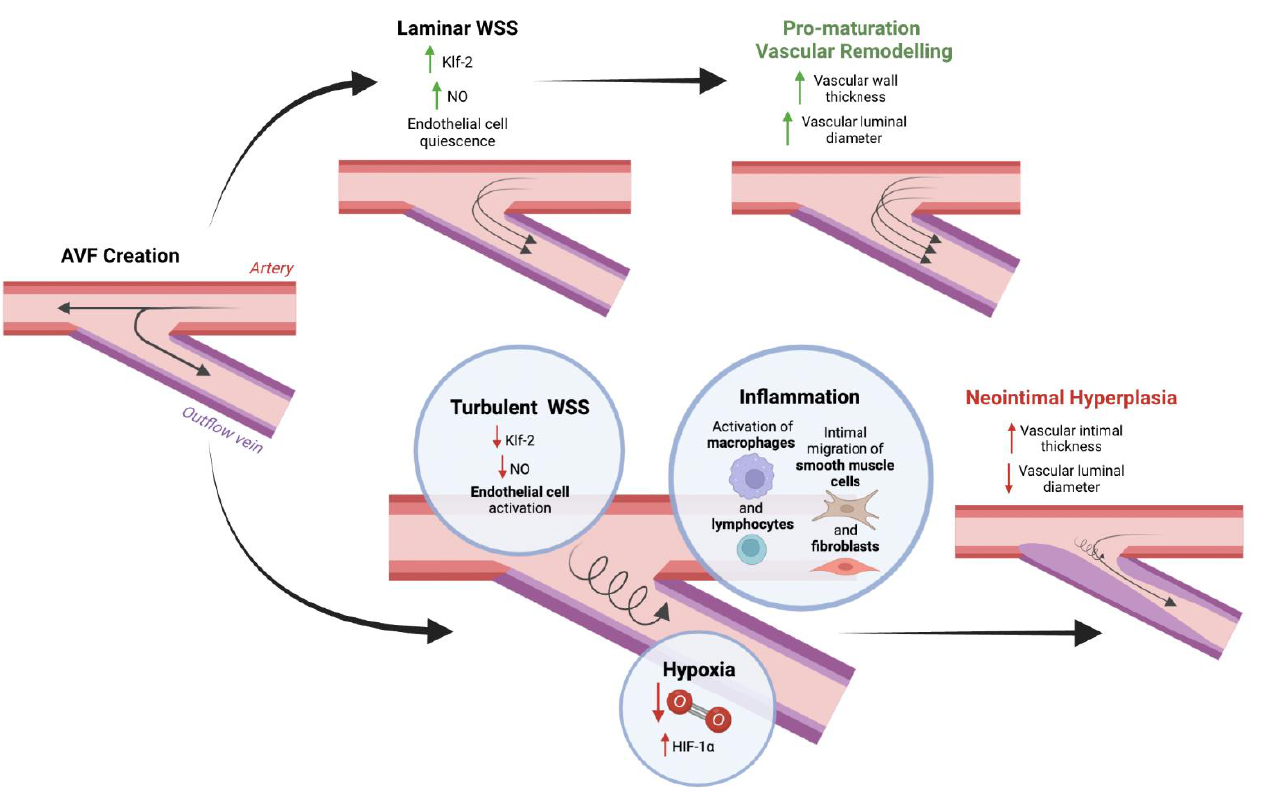
Figure 2. Pathways that lead to AVF maturation versus failure. Laminar WSS promotes outward remodeling. In contrast, the synergistic action of turbulent WSS, inflammation, and hypoxia promotes NIH. (Created with BioRender.com (accessed on 25 August 2022)) .